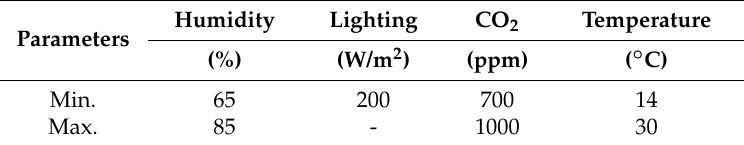
Table 3. Control parameters in greenhouse.